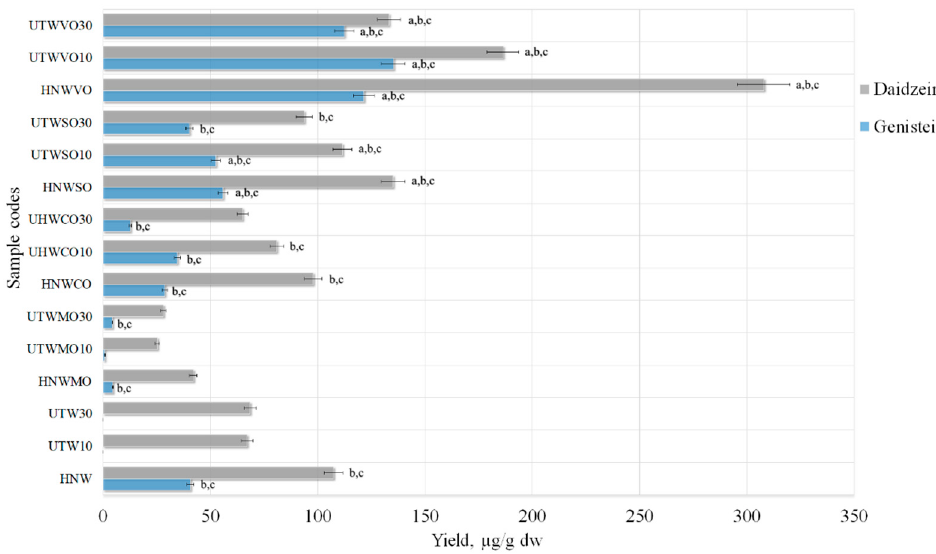
Figure 8. Quantitative yield of isoflavone aglycones using excipients (1%). Control samples without excipients (HNW; UTW10; UTW30), samples with magnesium aluminometasilicate (HNEMO; UTEMO10; UTEMO30), croscarmellose sodium (HNWCO; UHWCO10; UHWCO30), sodium carboxymethyl starch (HNWSO; UTWSO10; UTWSO30) and vinylpyrrolidone-vinyl acetate copolymer (HNWVO; UTWVO10; UTWVO30). a p < 0.05 vs. HNW, b p < 0.05 vs. UTW10, c p < 0.05 vs. UTW30. Sample codes and preparation conditions are displayed in Table 2.